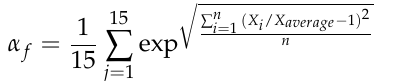
Figure 9. Binary images of the carbon fibers after image processing from Figure 8 with different fiber contents: ( a ) 0.5 wt.%; ( b ) 1.0 wt.%; ( c ) 2.0 wt.%; ( d ) 3.0 wt.%; ( e ) 4.0 wt.%.